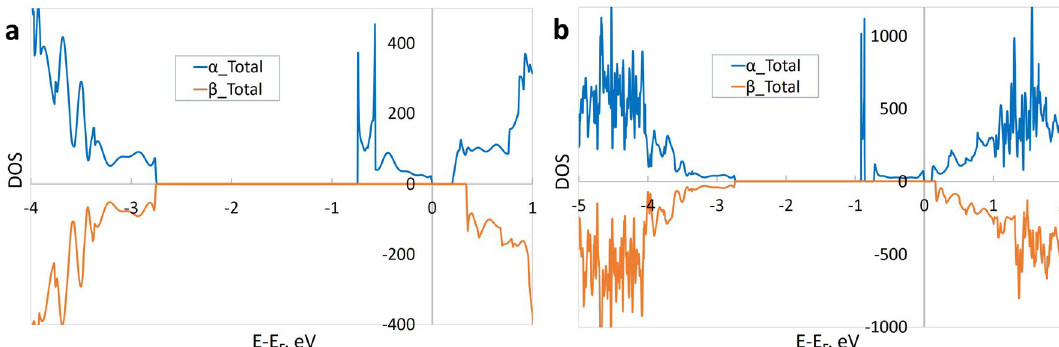
Figure 1. The electronic DOS for slabs with oxygen vacancy, total spin S z = 1. ( a ) V O in the central layer of the slab (space group SG 1); ( b ) V O on the surface of the slab (SG 6). α_Total, β_Total—total DOS for alpha- and beta- (spin up/down) electrons; the zero value of the energy corresponds to the Fermi